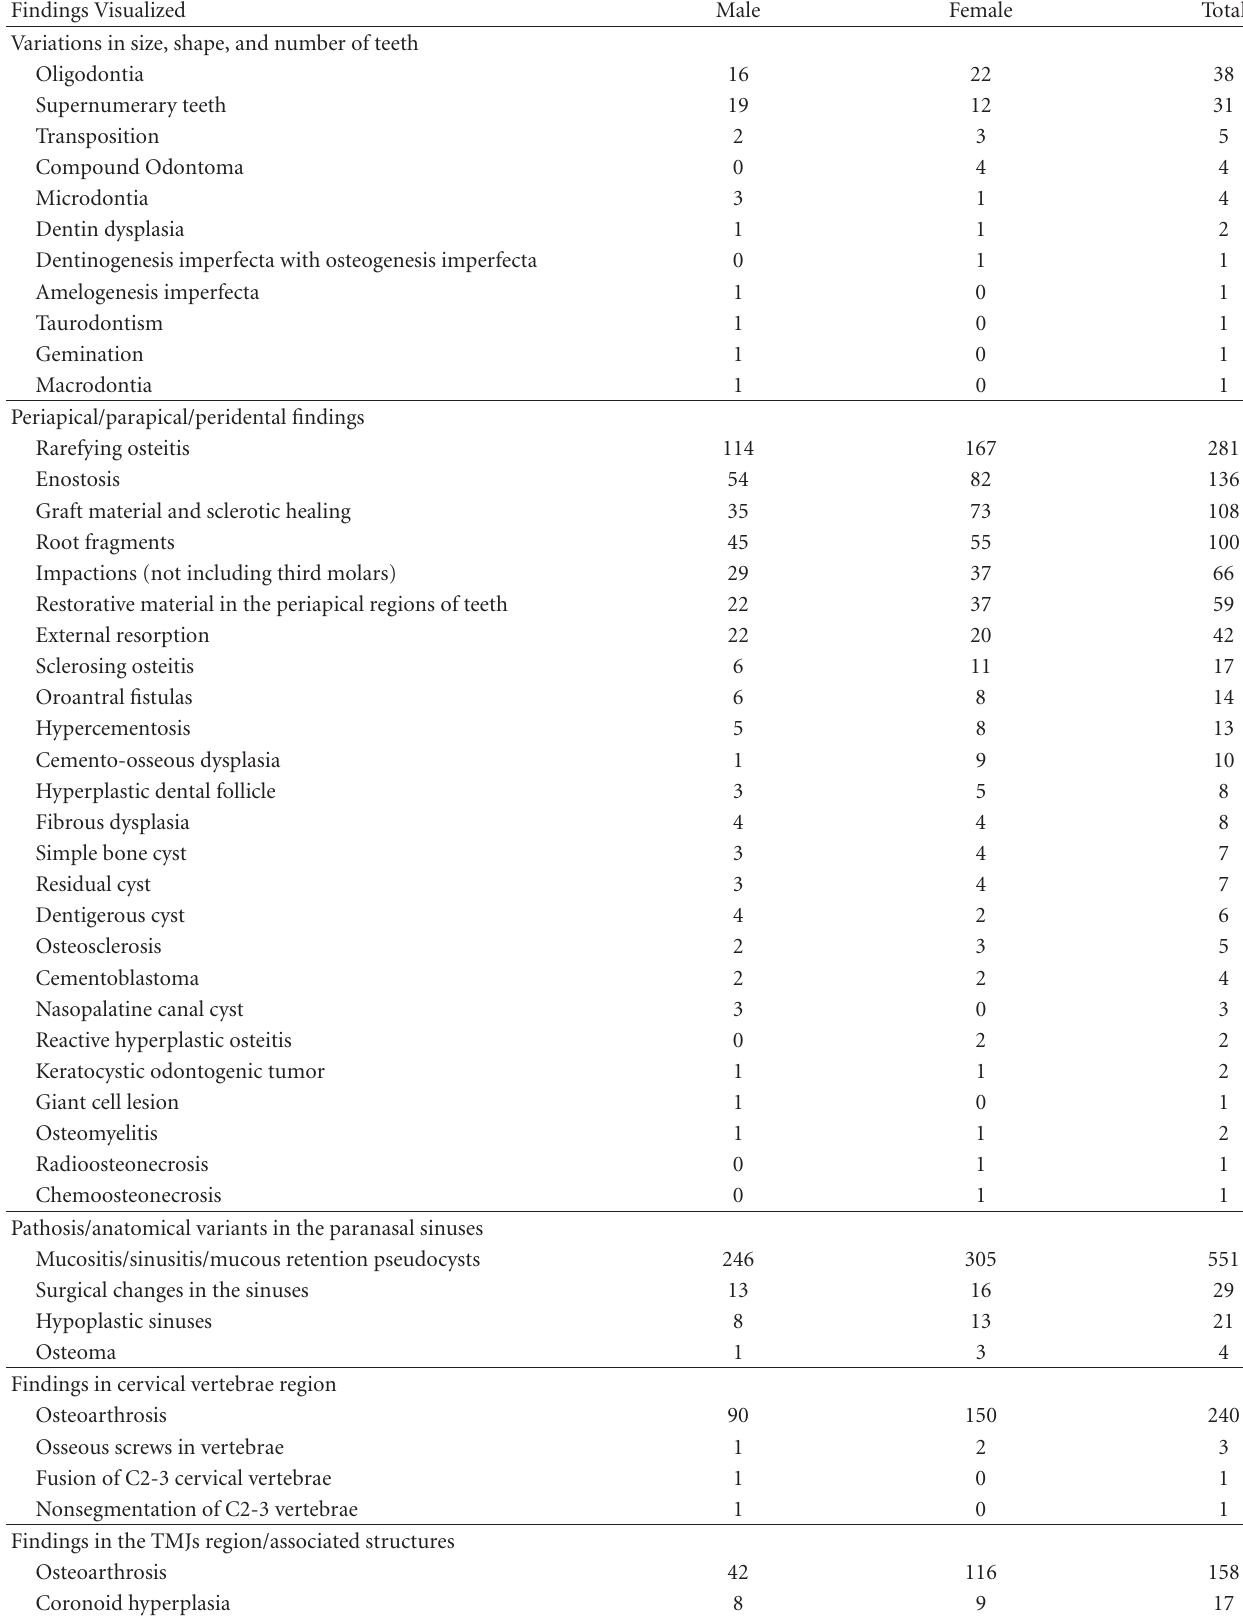
Table 3: Summary of all the findings seen in the 1000 scans (318 males and 682 females). Findings